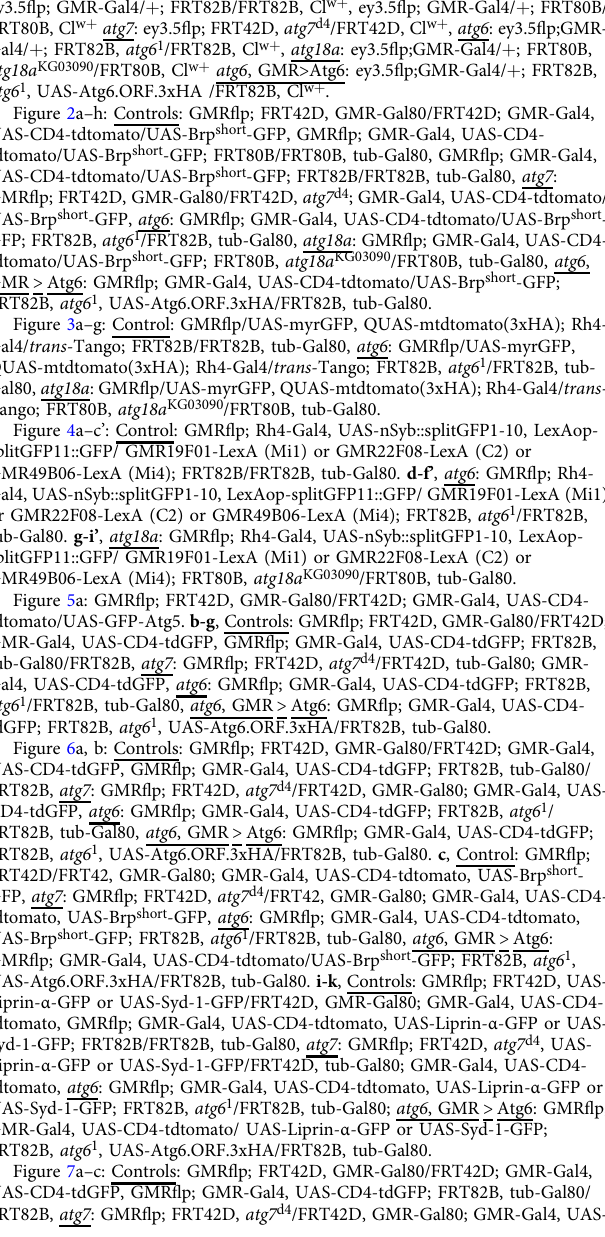
Drosophila genotypes . Figure 1a – i: Controls: ey3.5 fl p; FRT42D/FRT42D, Cl w + , ey3.5 fl p; GMR-Gal4/ + ; FRT82B/FRT82B, Cl w + , ey3.5 fl p; GMR-Gal4/ + ; FRT80B/ FRT80B, Cl w + atg7 : ey3.5 fl p; FRT42D, atg7 d4 /FRT42D, Cl w + , atg6 : ey3.5 fl p;GMR- Gal4/ + ; FRT82B, atg6 1 /FRT82B, Cl w + , atg18a : ey3.5 fl p;GMR-Gal4/ + ; FRT80B, atg18a KG03090 /FRT80B, Cl w + atg6 , GMR>Atg6: ey3.5 fl p;GMR-Gal4/ + ; FRT82B, atg6 1 , UAS-Atg6.ORF.3xHA /FRT82B, Cl w + . Figure 2a – h: Controls: GMR fl p; FRT42D, GMR-Gal80/FRT42D; GMR-Gal4, UAS-CD4-tdtomato/UAS-Brp short -GFP, GMR fl p; GMR-Gal4, UAS-CD4- tdtomato/UAS-Brp short -GFP; FRT80B/FRT80B, tub-Gal80, GMR fl p; GMR-Gal4, UAS-CD4-tdtomato/UAS-Brp short -GFP; FRT82B/FRT82B, tub-Gal80, atg7 : GMR fl p; FRT42D, GMR-Gal80/FRT42D, atg7 d4 ; GMR-Gal4, UAS-CD4-tdtomato/ UAS-Brp short -GFP, atg6 : GMR fl p; GMR-Gal4, UAS-CD4-tdtomato/UAS-Brp short - GFP; FRT82B, atg6 1 /FRT82B, tub-Gal80, atg18a : GMR fl p; GMR-Gal4, UAS-CD4- tdtomato/UAS-Brp short -GFP; FRT80B, atg18a KG03090 /FRT80B, tub-Gal80, atg6 , GMR> Atg6: GMR fl p; GMR-Gal4, UAS-CD4-tdtomato/UAS-Brp short -GFP; FRT82B, atg6 1 , UAS-Atg6.ORF.3xHA/FRT82B, tub-Gal80. Figure 3a – g: Control: GMR fl p/UAS-myrGFP, QUAS-mtdtomato(3xHA); Rh4- Gal4/ trans -Tango; FRT82B/FRT82B, tub-Gal80, atg6 : GMR fl p/UAS-myrGFP, QUAS-mtdtomato(3xHA); Rh4-Gal4/ trans -Tango; FRT82B, atg6 1 /FRT82B, tub- Gal80, atg18a : GMR fl p/UAS-myrGFP, QUAS-mtdtomato(3xHA); Rh4-Gal4/ trans - Tango; FRT80B, atg18a KG03090 /FRT80B, tub-Gal80. Figure 4a – c ’ : Control: GMR fl p; Rh4-Gal4, UAS-nSyb::splitGFP1-10, LexAop- splitGFP11::GFP/ GMR19F01-LexA (Mi1) or GMR22F08-LexA (C2) or GMR49B06-LexA (Mi4); FRT82B/FRT82B, tub-Gal80. d-f ’ , atg6 : GMR fl p; Rh4- Gal4, UAS-nSyb::splitGFP1-10, LexAop-splitGFP11::GFP/ GMR19F01-LexA (Mi1) or GMR22F08-LexA (C2) or GMR49B06-LexA (Mi4); FRT82B, atg6 1 /FRT82B, tub-Gal80. g-i ’ , atg18a : GMR fl p; Rh4-Gal4, UAS-nSyb::splitGFP1-10, LexAop- splitGFP11::GFP/ GMR19F01-LexA (Mi1) or GMR22F08-LexA (C2) or GMR49B06-LexA (Mi4); FRT80B, atg18a KG03090 /FRT80B, tub-Gal80. Figure 5a: GMR fl p; FRT42D, GMR-Gal80/FRT42D; GMR-Gal4, UAS-CD4- tdtomato/UAS-GFP-Atg5. b-g , Controls: GMR fl p; FRT42D, GMR-Gal80/FRT42D; GMR-Gal4, UAS-CD4-tdGFP, GMR fl p; GMR-Gal4, UAS-CD4-tdGFP; FRT82B, tub-Gal80/FRT82B, atg7 : GMR fl p; FRT42D, atg7 d4 /FRT42D, tub-Gal80; GMR- Gal4, UAS-CD4-tdGFP, atg6 : GMR fl p; GMR-Gal4, UAS-CD4-tdGFP; FRT82B, atg6 1 /FRT82B, tub-Gal80, atg6 , GMR> Atg6: GMR fl p; GMR-Gal4, UAS-CD4- tdGFP; FRT82B, atg6 1 , UAS-Atg6.ORF.3xHA/FRT82B, tub-Gal80. Figure 6a, b: Controls: GMR fl p; FRT42D, GMR-Gal80/FRT42D; GMR-Gal4, UAS-CD4-tdGFP, GMR fl p; GMR-Gal4, UAS-CD4-tdGFP; FRT82B, tub-Gal80/ FRT82B, atg7 : GMR fl p; FRT42D, atg7 d4 /FRT42D, GMR-Gal80; GMR-Gal4, UAS- CD4-tdGFP, atg6 : GMR fl p; GMR-Gal4, UAS-CD4-tdGFP; FRT82B, atg6 1 / FRT82B, tub-Gal80, atg6 , GMR> Atg6: GMR fl p; GMR-Gal4, UAS-CD4-tdGFP; FRT82B, atg6 1 , UAS-Atg6.ORF.3xHA/FRT82B, tub-Gal80. c , Control: GMR fl p; FRT42D/FRT42, GMR-Gal80; GMR-Gal4, UAS-CD4-tdtomato, UAS-Brp short - GFP, atg7 : GMR fl p; FRT42D, atg7 d4 /FRT42, GMR-Gal80; GMR-Gal4, UAS-CD4- tdtomato, UAS-Brp short -GFP, atg6 : GMR fl p; GMR-Gal4, UAS-CD4-tdtomato, UAS-Brp short -GFP; FRT82B, atg6 1 /FRT82B, tub-Gal80, atg6 , GMR >Atg6: Liprin- α -GFP or UAS-Syd-1-GFP/FRT42D, GMR-Gal80; GMR-Gal4, UAS-CD4- tdtomato, GMR fl p; GMR-Gal4, UAS-CD4-tdtomato, UAS-Liprin- α -GFP or UAS- Syd-1-GFP; FRT82B/FRT82B, tub-Gal80, atg7 : GMR fl p; FRT42D, atg7 d4 , UAS- Liprin- α -GFP or UAS-Syd-1-GFP/FRT42D, tub-Gal80; GMR-Gal4, UAS-CD4- tdtomato, atg6 : GMR fl p; GMR-Gal4, UAS-CD4-tdtomato, UAS-Liprin- α -GFP or UAS-Syd-1-GFP; FRT82B, atg6 1 /FRT82B, tub-Gal80; atg6 , GMR >Atg6: GMR fl p; Figure 7a – c: Controls: GMR fl p; FRT42D, GMR-Gal80/FRT42D; GMR-Gal4, UAS-CD4-tdGFP, GMR fl p; GMR-Gal4, UAS-CD4-tdGFP; FRT82B, tub-Gal80/ FRT82B, atg7 : GMR fl p; FRT42D, atg7 d4 /FRT42D, GMR-Gal80; GMR-Gal4,